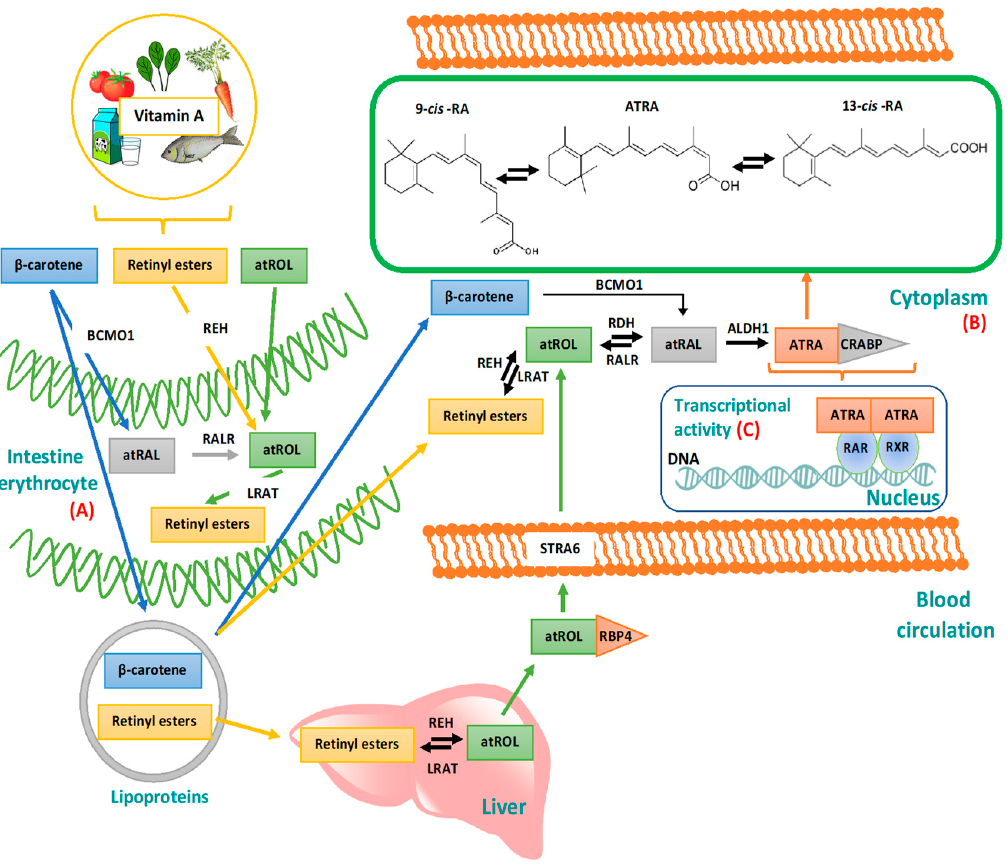
Figure 2. Retinoids metabolism in humans from food intake to ATRA. Graphical representation of the metabolism, transport and fate of derivatives of Vitamin A in: ( A ) gut and bloodstream, ( B ) cytoplasm, and ( C ) nucleus. Retinoids: atRAL, all-trans RetinALdehyde; atROL, all-trans RetinOL; ATRA, All-Trans Retinoic Acid. Proteins: RBP, Retinol Binding Protein; STRA6, STimulated by Retinoic Acid 6; CRABP, Cellular Retinoic Acid BP; RAR, Retinoic Acid Receptor; RXR, Retinoid X Receptor. Enzymes: BCMO1, β -carotene MonoOxigenase 1; REH, Retinyl Ester Hydrolase; RALR, RetinAL Reductase; LRAT, Lecithin Retinol AcetylTransferase; RDH, Retinol DeHydrogenase; ALDH1, ALdehyde DeHydrogenase